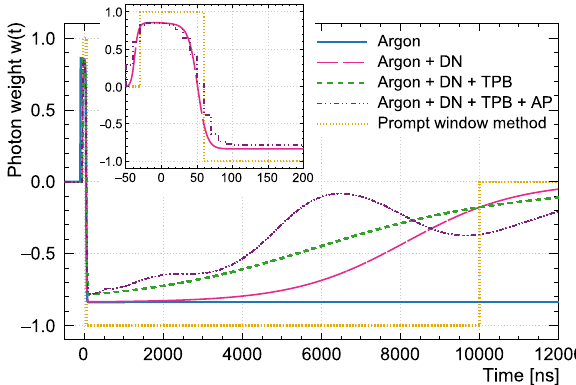
Fig. 9 The L recoil weight-functions from Eq. (6) calculated for pho- ton detection PDFs that take into account different components of the detector response are shown. The blue solid line considers only the LAr scintillation (Argon), the pink long-dashed line adds dark noise (DN), the green short-dash line includes the slow component of TPB fluo- rescence (TPB), and the purple dot-dash line adds afterpulsing (AP). This is compared to the equivalent weight function used in the F prompt PP (yellow dotted line). The insert zooms in on the time region from − 50 to 200ns; for reasons of legibility, only three of the lines are shown here. Note that the detector’s time resolution is included in the PDFs the photon weights are based on. The weight can be interpreted as